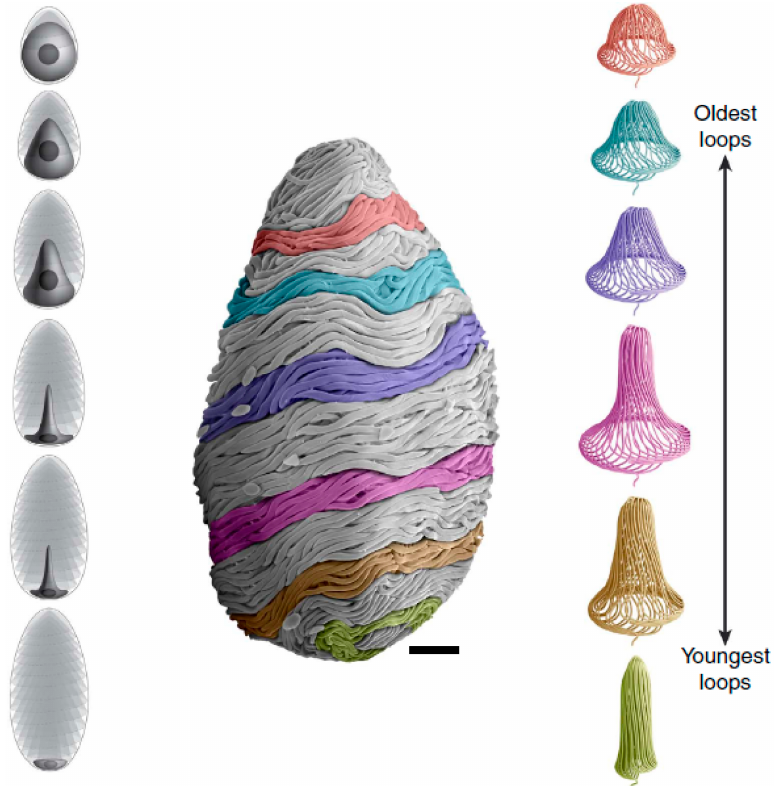
Figure 4. Developmental series of GTCs and thread coiling. ( Left ) The GTC nucleus in initially round in shape, occupying most of the space within the cell, but over time it takes on a spindle shape as more loops of thread are laid down, until the nucleus is just a disc at the basal end of a mature GTC. ( Right ) Successive arrangements of thread loops reflect the morphology of the nucleus at the time they were formed. ( Center ) The arrangement of the thread loops facilitates the rapid unravelling of the thread in secreted mature GTCs. Scare bar is 10 μ m [24].